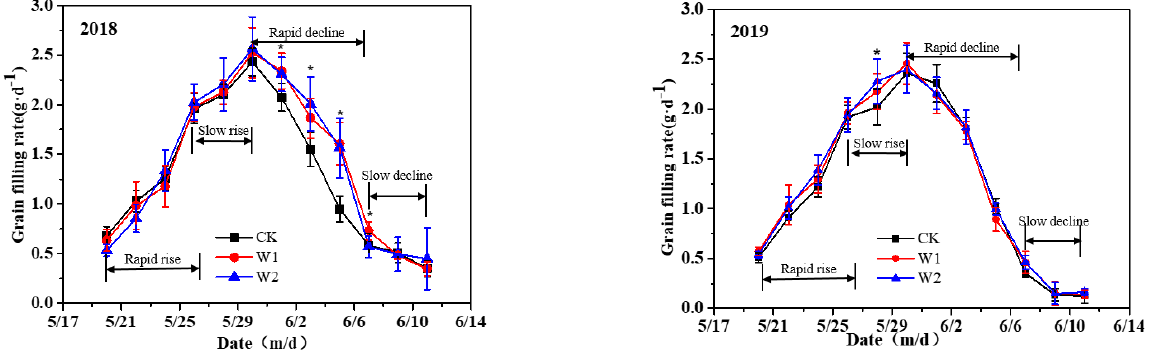
Figure 8. Grain filling rate during the grain filling stage under different treatments in 2018 and 2019. The values are the mean ± standard error ( n = 3). * = significant at a probability level of p < 0.05 according to the Least Significant Difference test. W1, W2, and CK represent 2.5 mm, 5 mm, and no irrigation treatments during dry-hot wind condition,